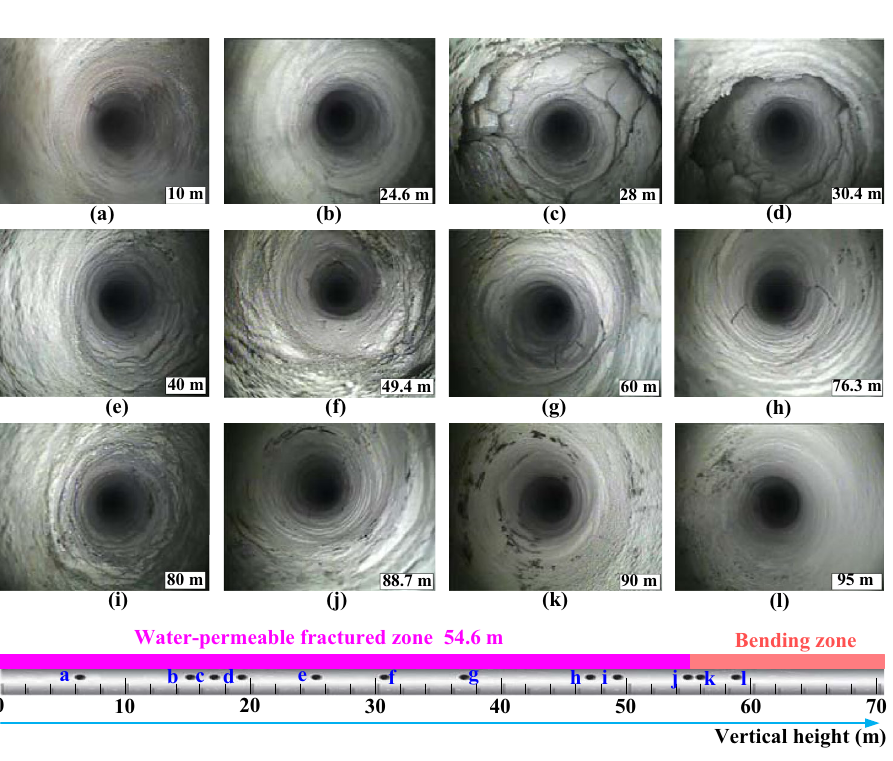
Figure 12. Borehole camera images and corresponding WPFZ range.